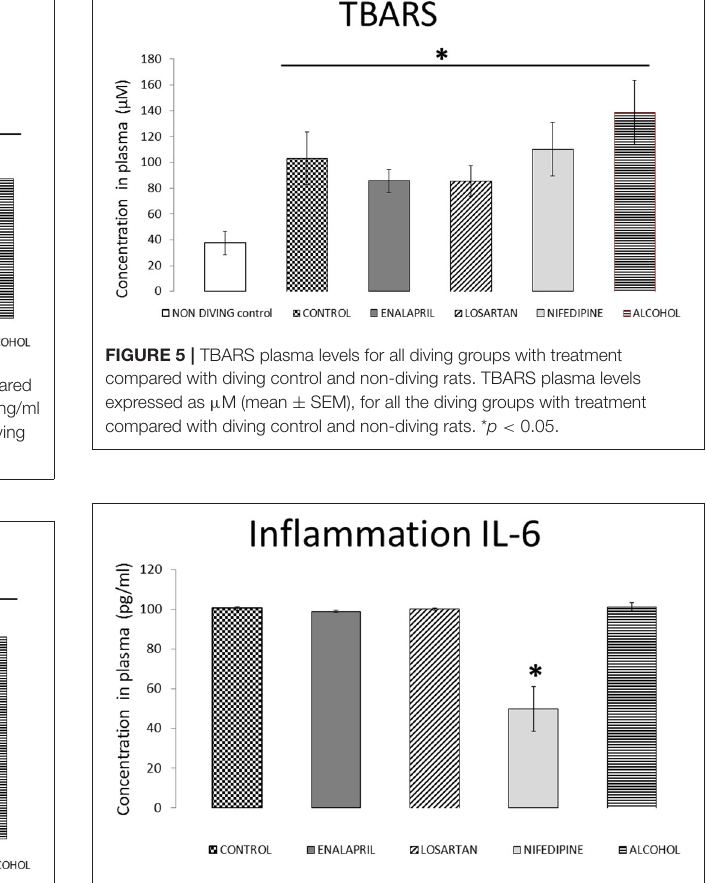
FIGURE 6 | IL-6 plasma levels for all diving groups with treatment compared with diving control. IL-6 plasma levels expressed as pg/ml (mean ± SEM), for all the diving groups with treatment compared with diving control. * p <